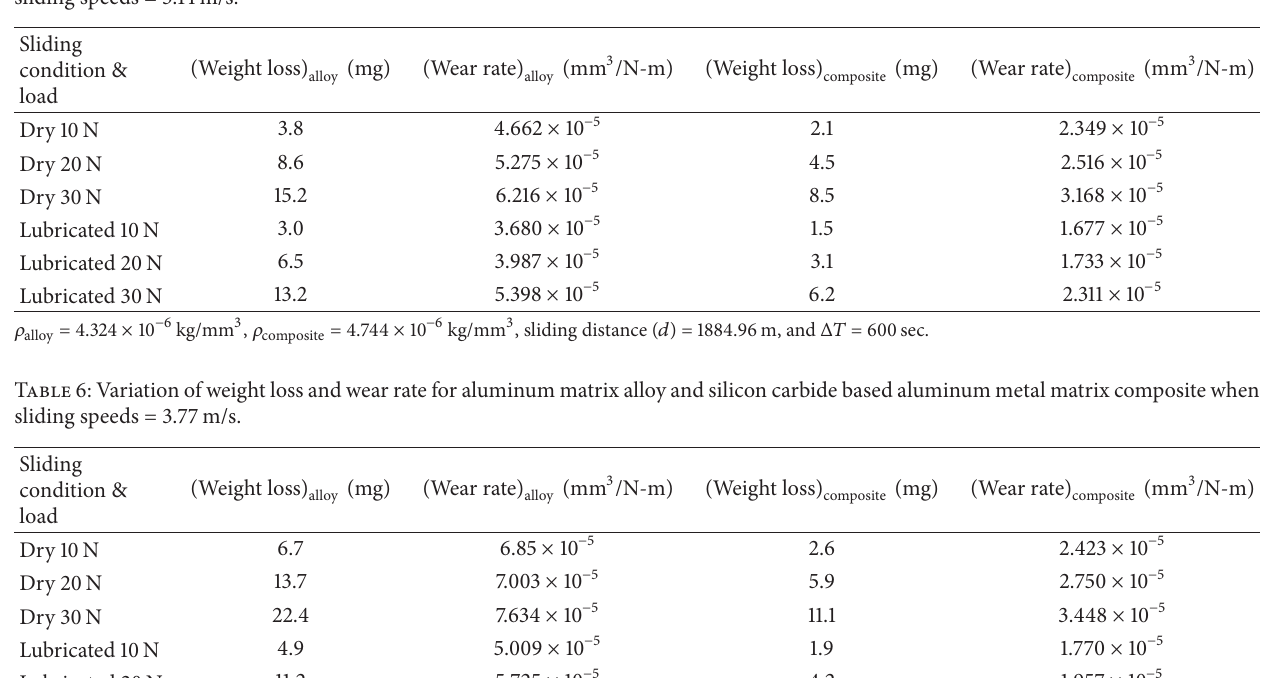
Table 5: Variation of weight loss and wear rate for aluminum matrix alloy and silicon carbide based aluminum metal matrix composite when sliding speeds = 3.14 m/s.